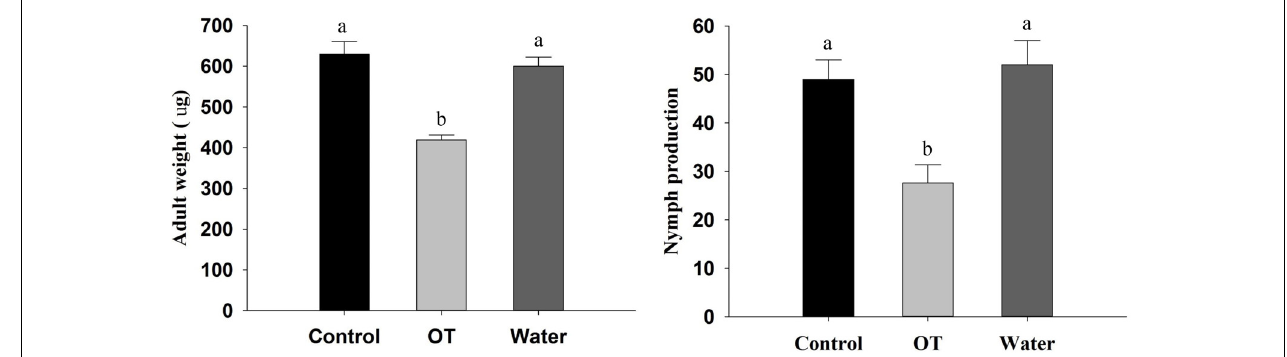
FIGURE 1 | Performance of M. persicae reared on β -ocimene treated and control Chinese cabbages. OT, β -ocimene treated Chinese cabbage; CK, CH 2 Cl 2 treated Chinese cabbage; Water, water treated Chinese cabbage, which was used as negative control. Different letters over the bars designate a significant difference at P <